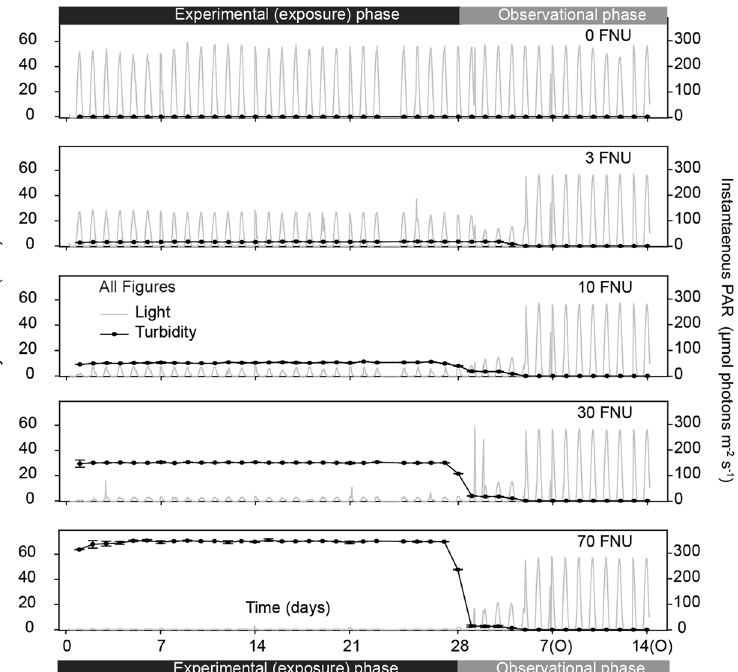
Figure 1. Physical parameters throughout the experiment. Turbidity (FNU) (mean ± SE) and instantaneous light (PAR, µ mol photon m − 2 s − 1 ) (mean) (n = 2 replicate tanks per treatment) experienced in each scenario (0, 3, 10, 30 and 70 FNU, but see also Table 1) throughout the 28 d experimental (exposure) and 14 d observational periods.